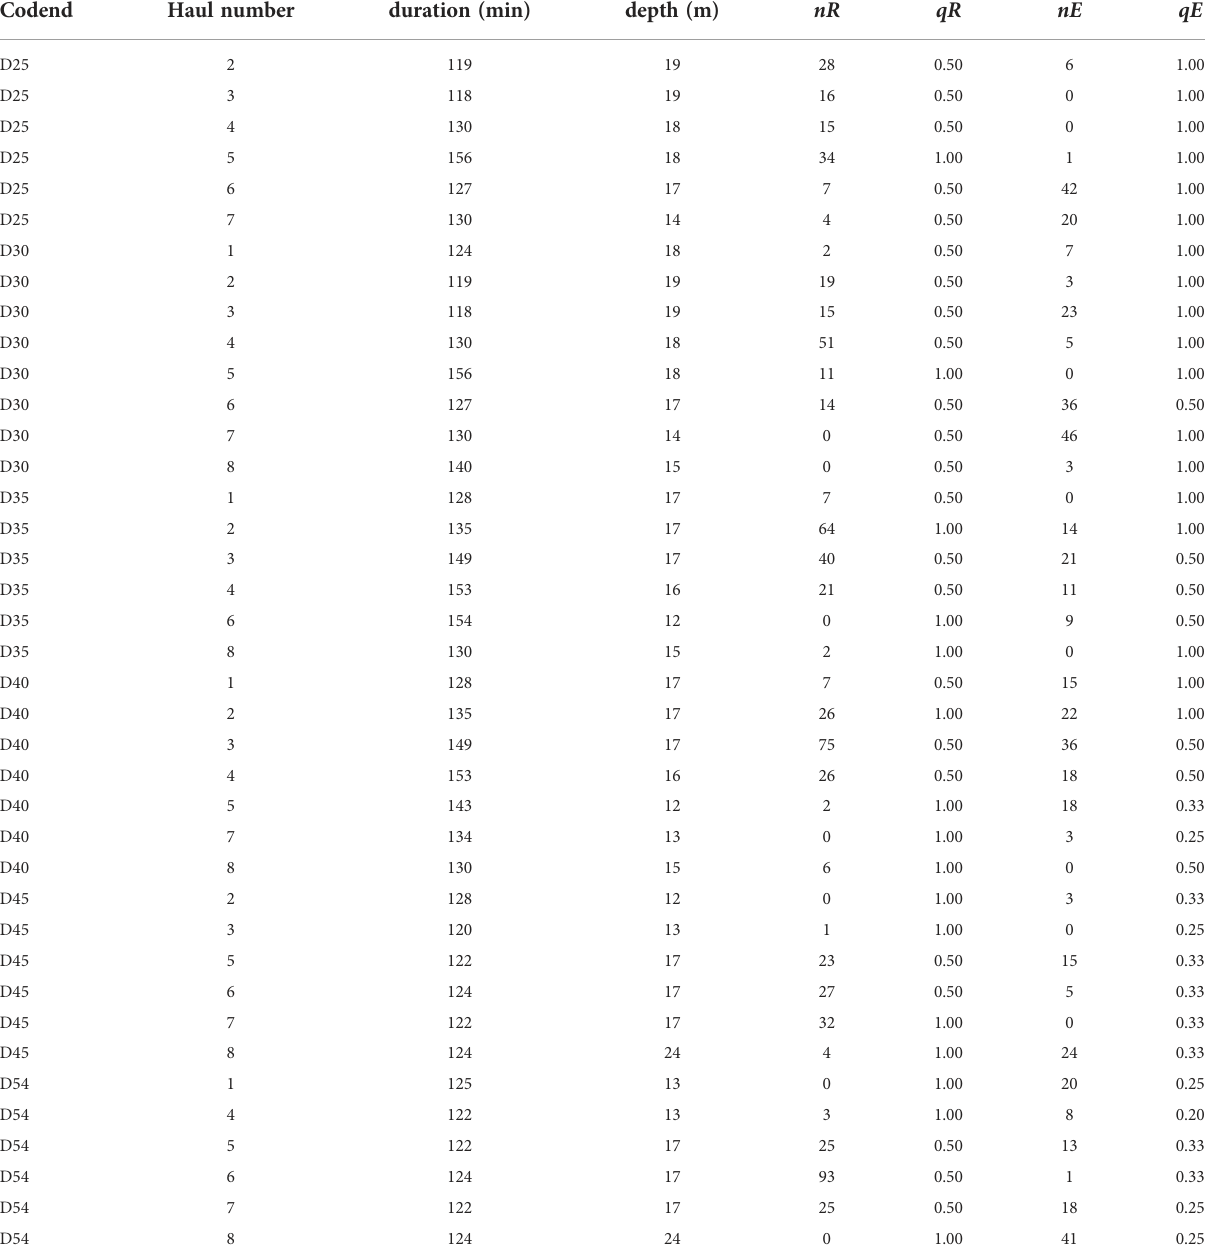
TABLE 2 Overview of the fi shing condition and catch information of all the hauls regarding the serial number, duration (min), depth (m), and number of shrimp length-measured from the codend ( nR ) and cover ( nE ). qR and qE refer to the sampling ratio from the codend and cover,